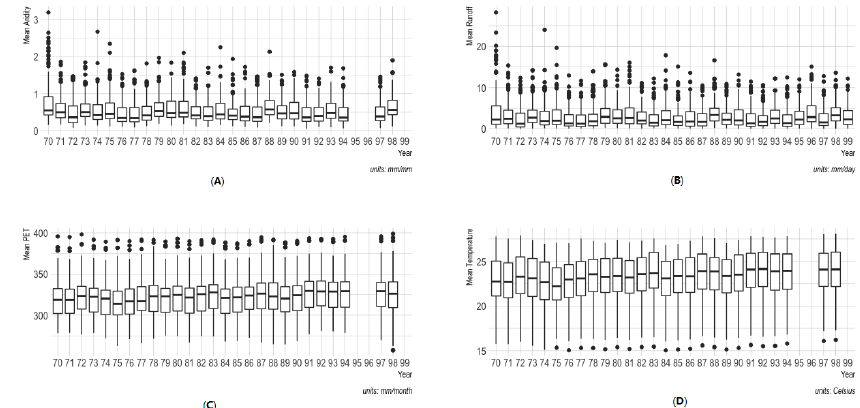
Figure A1. Boxplot describing data from 1970–1999 in the Central American Region, for each of the following variables: ( A ) Aridity. ( B ) Runoff. ( C ) PET. ( D ) Temperature.